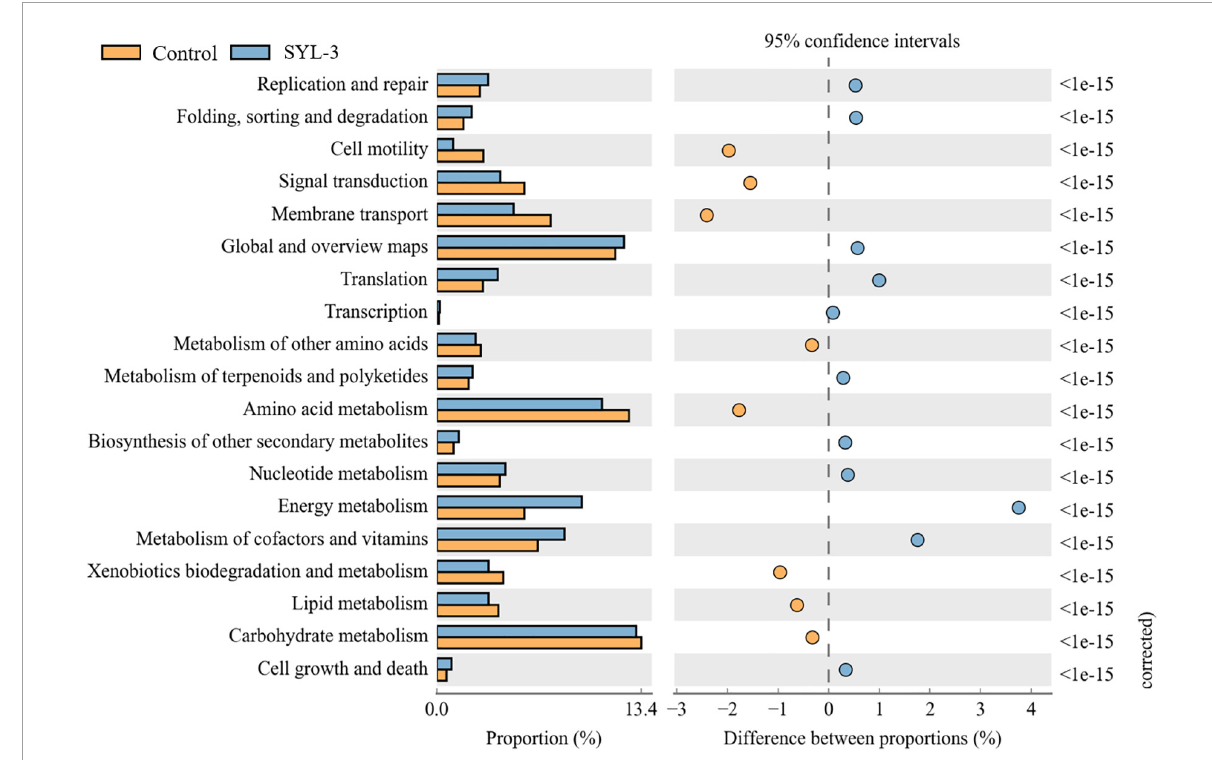
FIGURE8 Metagenomes predicted by PICRUSt show significant differences in the functionality between SYL-3 treatment samples and